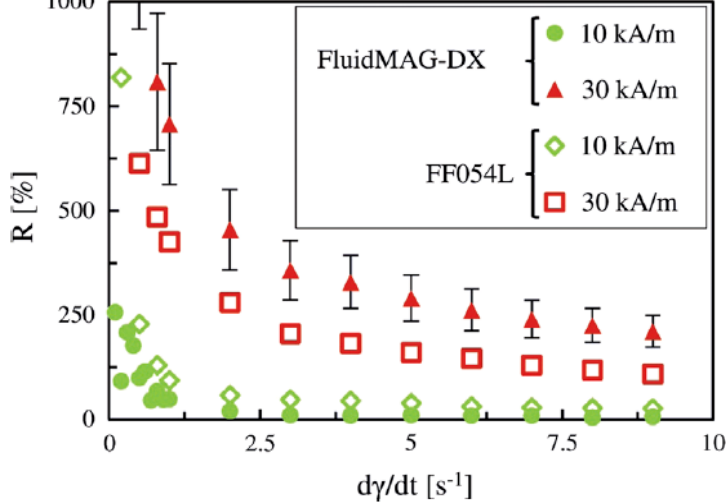
Figure 26. The MVE in the fluidMAG-DX-100 nm in comparison with the FF054L for two values of intensity of magnetic field. Reprinted with permission from Reference [16].